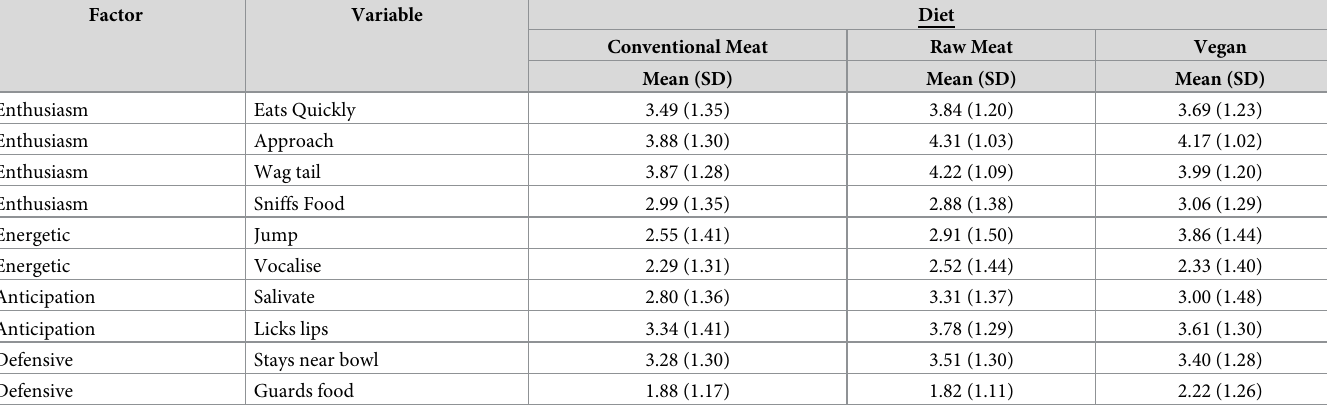
Table 2. Descriptive statistics of the owner reported food-oriented behaviours, with range Strongly Disagree (1) to Strongly Agree (5).